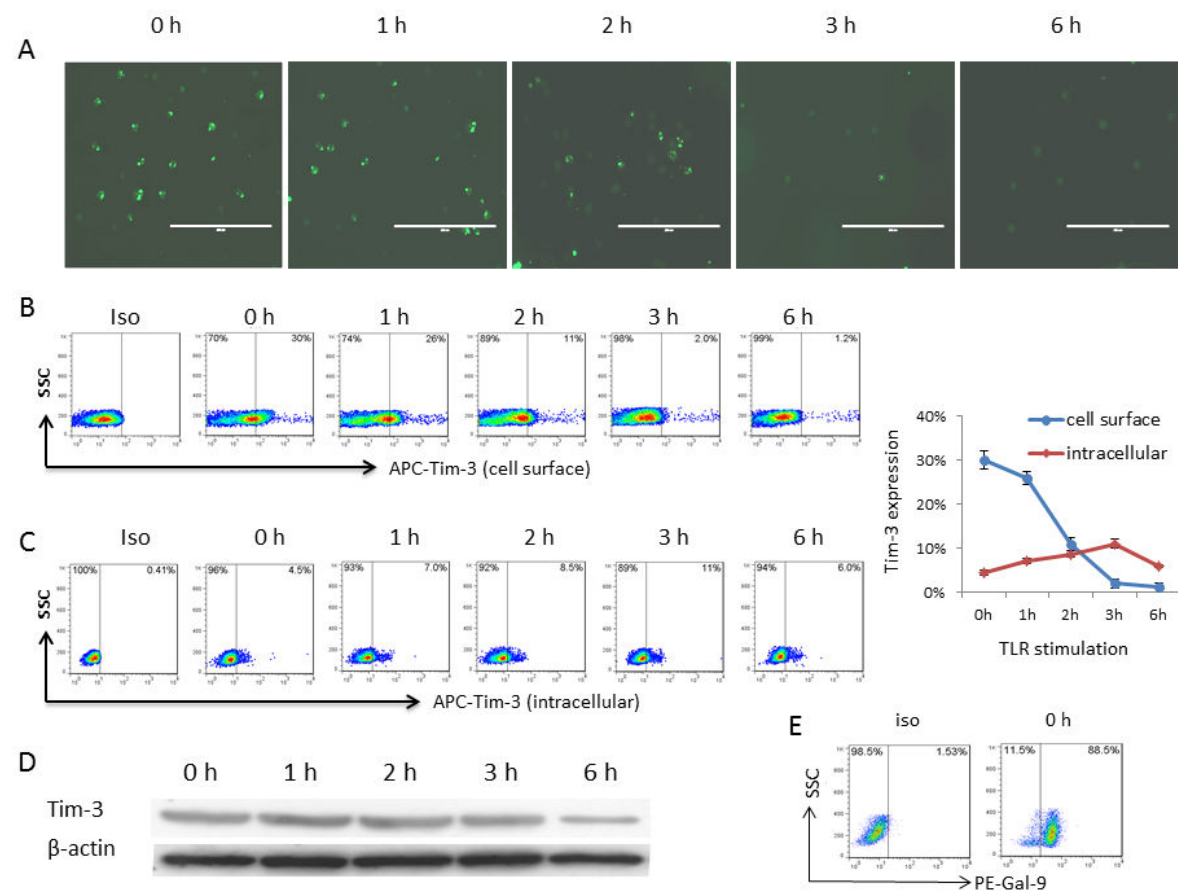
Figure 3. Tim-3 internalization from cell surface into cytoplasm of M/M with bounty of Gal-9 following TLR stimulation. A) Φ The kinetic presentation of Tim-3 on the surface of M/M following TLR stimulation analyzed by immunofluorescent microscopy. Ø Tim-3 on the surface of live M/M was labeled with a primary Tim-3 antibody (Santa Cruz); the cells were stimulated with LPS/R848 Ø for 0, 1, 2, 3, 6 h, followed by staining with a fluorescence-conjugated secondary antibody and analysis by AMG fluorescence phase microscope. Magnification 20x for all panels and scale bar = 100 µm. B) The presentation of Tim-3 on the surface of M/M following Ø TLR stimulation analyzed by flow cytometry. M/M were stimulated with LPS/R848 for the same period of time (0, 1, 2, 3, 6 h), Ø immunostained for Tim-3 cell surface expression using a different source of antibody (eBioscience), and analyzed by flow cytometry as described in the Methods. Isotype-matched control antibodies (eBioscience) and fluorescence minus one (FMO) controls were used to determine background levels of staining and adjust multicolor compensation as gating strategy. Representative dot plots with percentages of cells in the gated area are shown. C) The presentation of Tim-3 inside the cytoplasm of M/M following TLR Ø stimulation analyzed by flow cytometry. First, M/M were incubated with 10 µg/ml of un-conjugated mAb (F38-2E2, Biolegend) to Ø saturate surface Tim-3 epitopes; after TLR stimulation for the same period of time and fixation/permeabilization procedures, staining of intracytoplasmatic Tim-3 epitopes was performed using the same clone of conjugated Tim-3 mAb (F38-2E2), followed by flow cytometric analysis. Representative dot plots with percentages of cells gated based on the same strategy are shown on the left. The percentage of Tim-3 presentation (mean ± SD) on the surface and intracellular of M/M following TLR stimulation analyzed by flow Ø cytometry from 3 independent experiments is shown on the right. D) The amount of Tim-3 in M/M following TLR stimulation Ø analyzed by Western blot. Purified M/M were stimulated with LPS/R848 for the same period of times, and total Tim-3 protein Ø expression was detected by Western blot as described in the Methods. E) Representative dot plots for intracellular Gal-9 detection in purified resting human M/M by flow cytometry. Ø